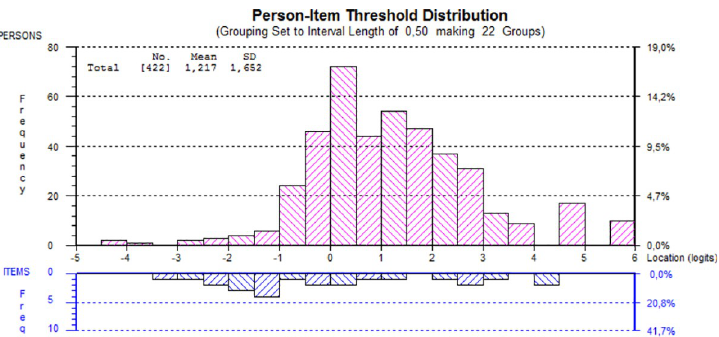
Fig 2. Person and item threshold distribution along the logit scale, analysis on two testlets. Higher values indicate higher Workplace Social Capital within the Workplace Social Capital scale of the COPSOQ